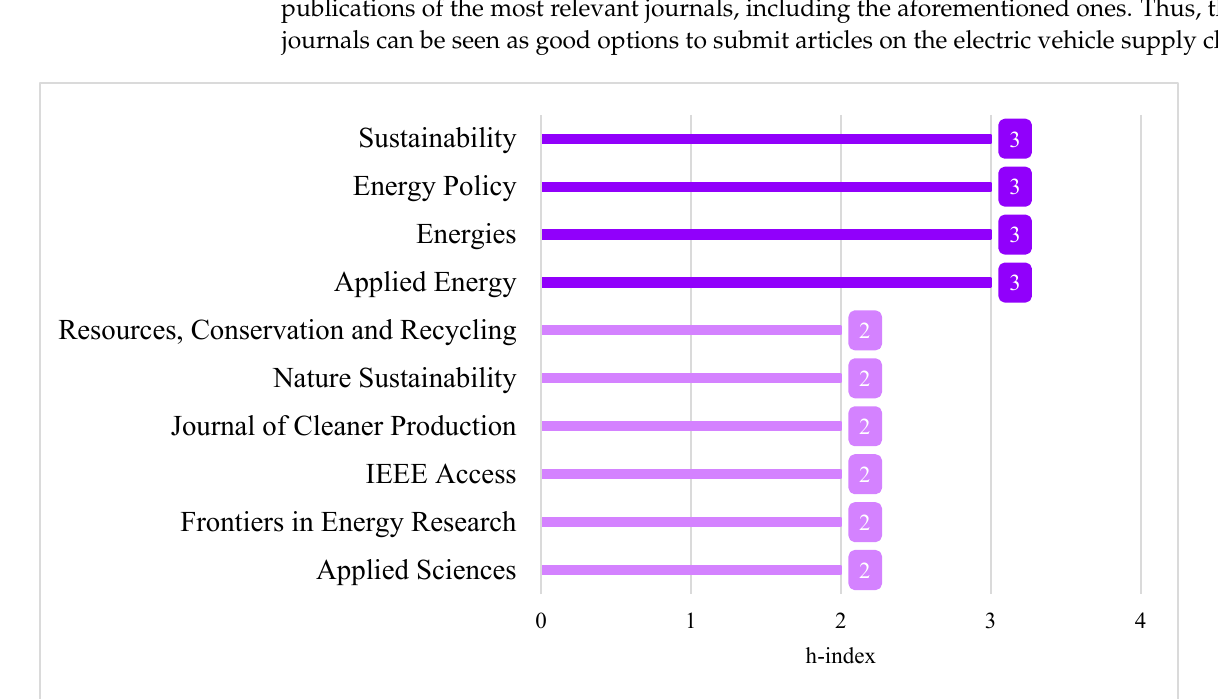
Figure 6. liImpact factor of journals. (Chart produced in Microsoft Excel).